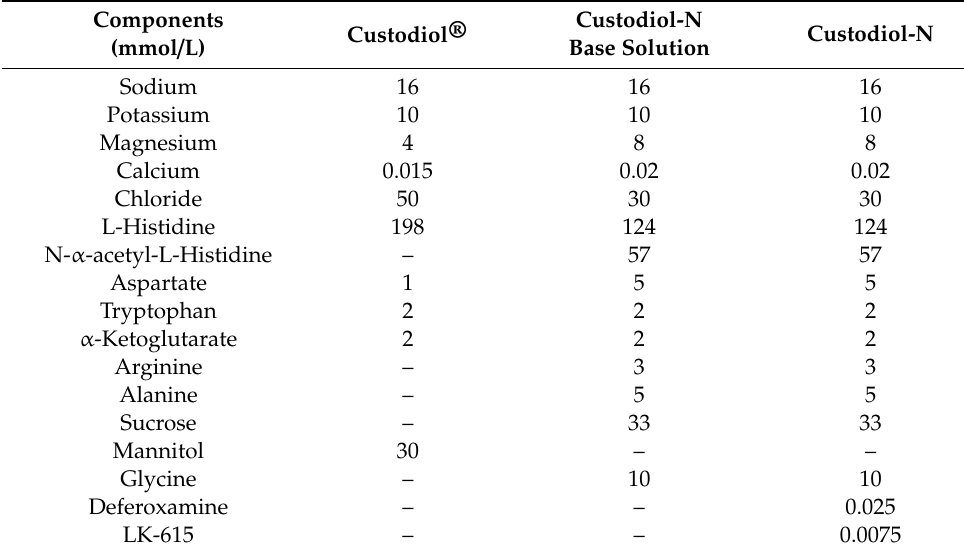
Table 1. Composition of the clinically used Custodiol ® and Custodiol-N